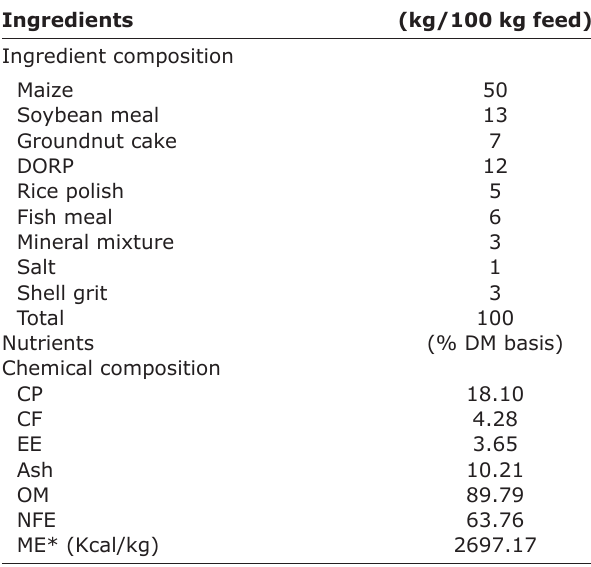
Table-1: The ingredients and chemical composition of control diet. Ingredients Ingredient